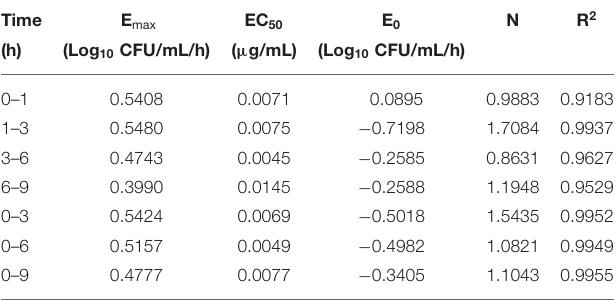
TABLE 2 | Main parameters between the cefquinome concentration and kill rate after sigmoid E max simulation. Time